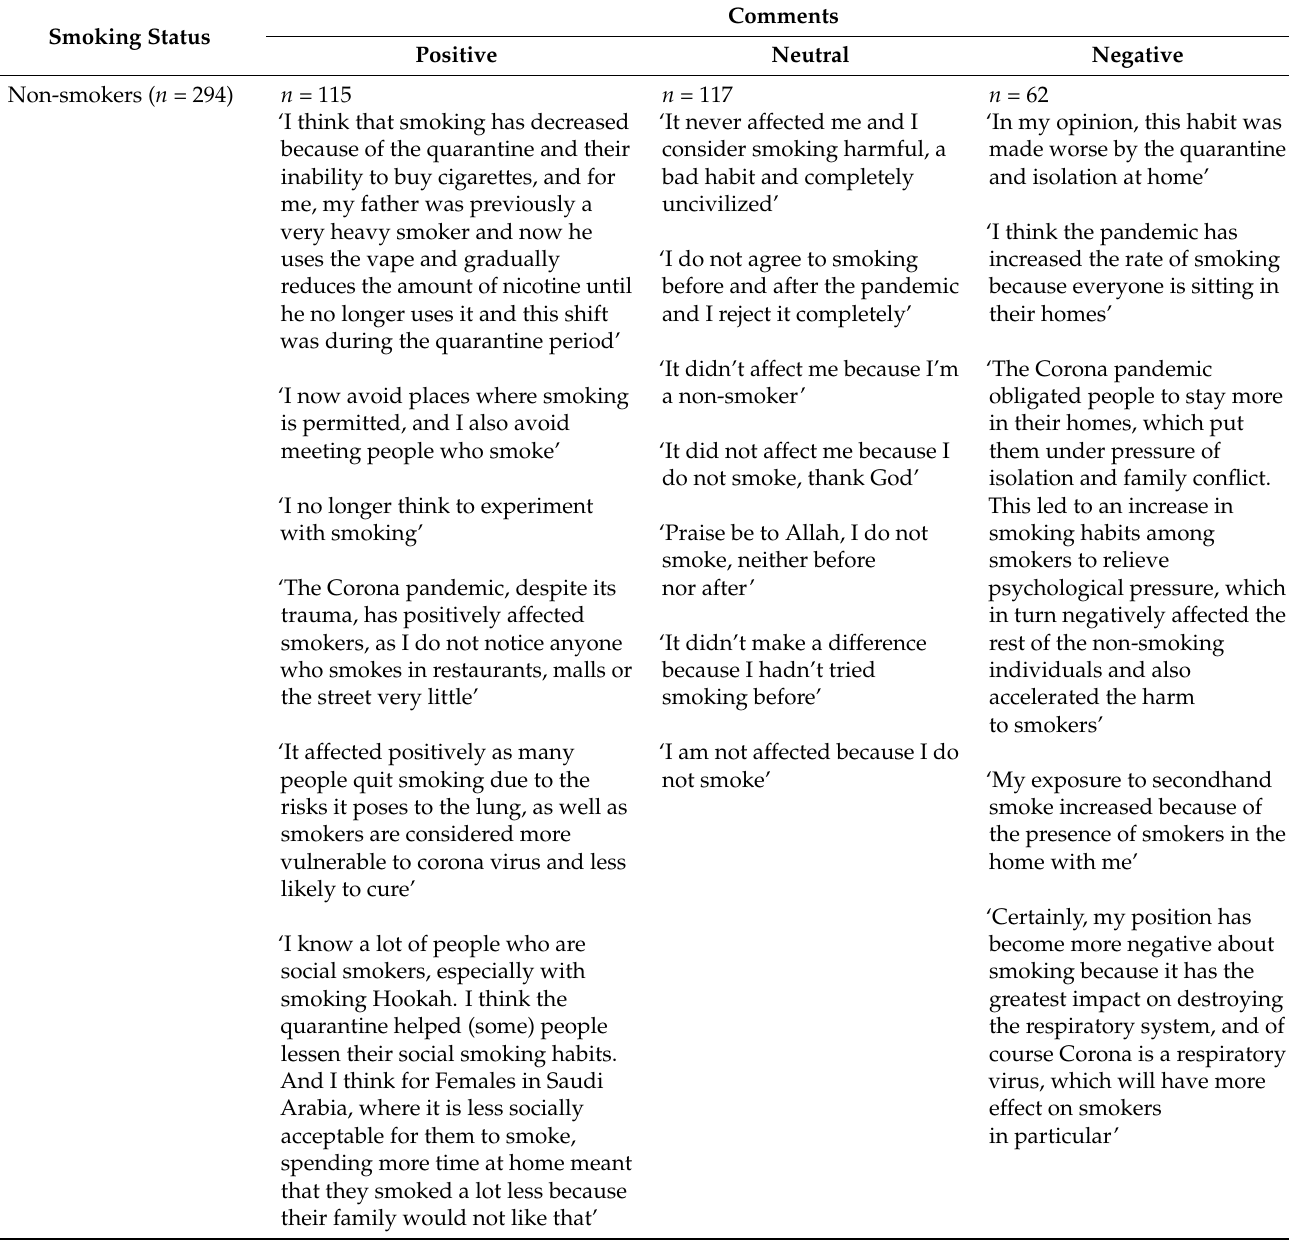
Table 4. Example quotes of the impact of COVID-19 on smoking from non-smokers, former smokers and smokers ( n = 374). Smoking